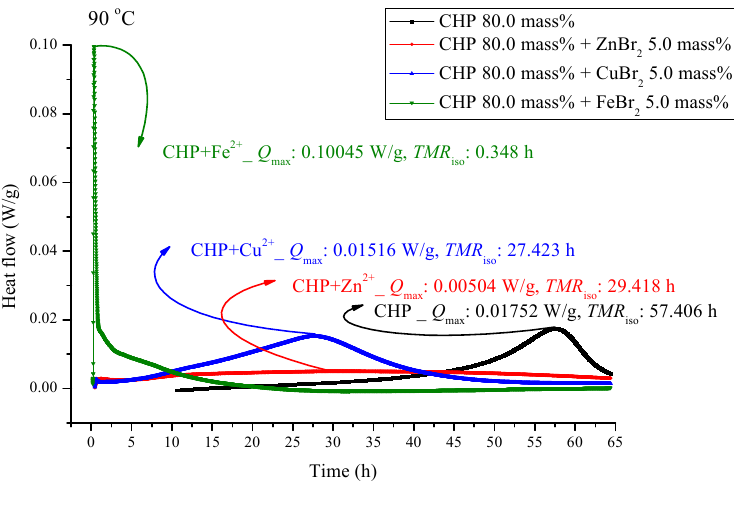
Figure 5. Heat flow versus temperature plot for 80.0 mass% CHP mixed with ZnBr 2 , CuBr 2 , or FeBr 2 , tested using TAM III scanning analysis at 90.0 °C.